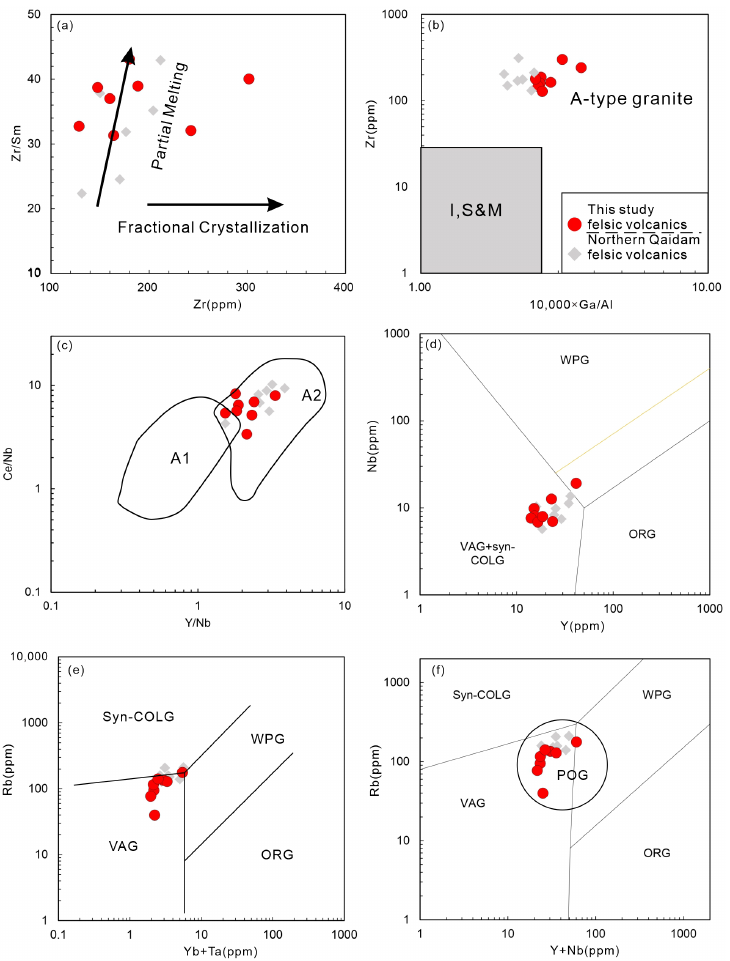
Figure 13. ( a ) Zr vs. Zr/Sm diagram, ( b ) 10,000 × Ga/Al vs. Zr diagram [120], ( c ) Nb - Y - Zr diagram [121], ( d ) Y vs. Nb diagram, ( e ) (Yb + Ta) vs. Rb diagram, and ( f ) (Y + Nb) vs. Rb diagram [122] for felsic volcanic rocks from the Maoniushan Formation. The data for felsic volcanic rocks in the NQ are from Zhu et al.